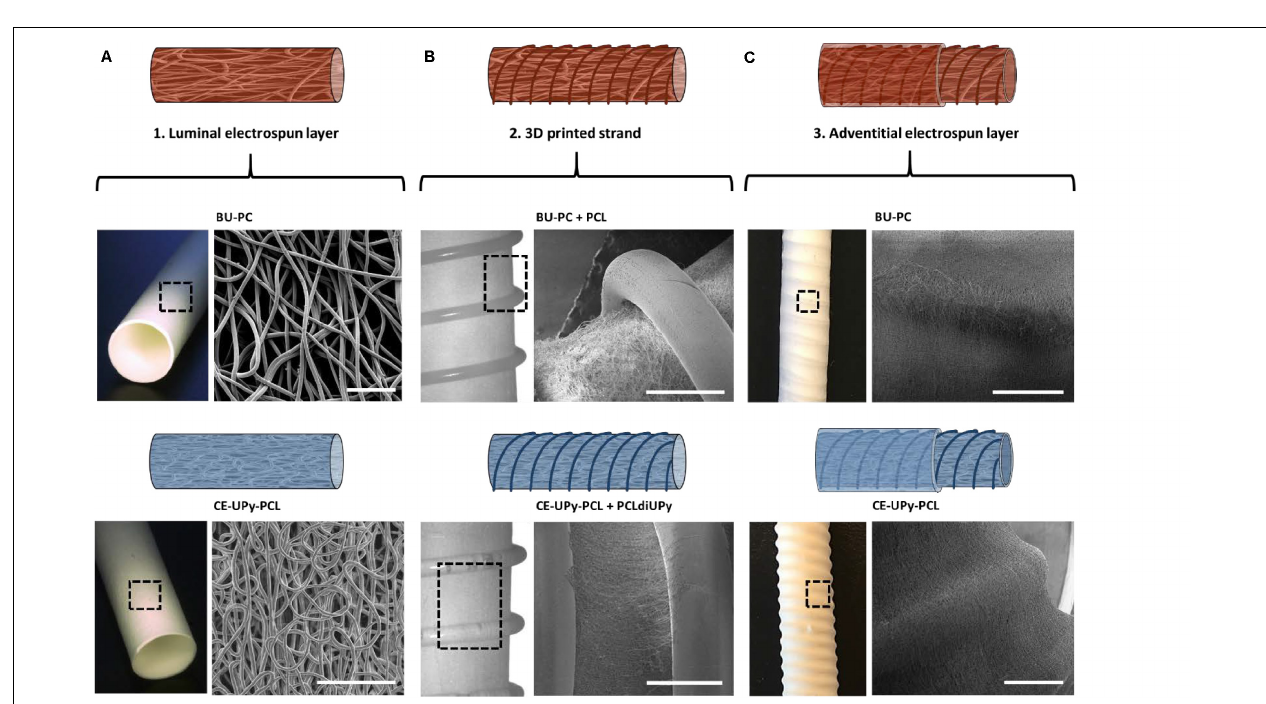
FIGURE 5 | Microstructural properties of the three-layered design. (A) Microscopic image of the first (luminal) electrospun tubular graft (6 mm diameter) consisting of interconnected microfibers. Scale bars represent 100 µ m. (B) Second layer composed of 3D printed polymer architecture. A well-attached printed PCL strand on top the PC-BU luminal layer was observed using scanning electron microscopy (SEM). The PCLdiUPy was printed on top of the luminal electrospun CE-UPy-PCL layer (C) Adventitial electrospun layer was electrospun on top of the 3D printed layer. Scale bars in panels (B,C) represent 1 mm.